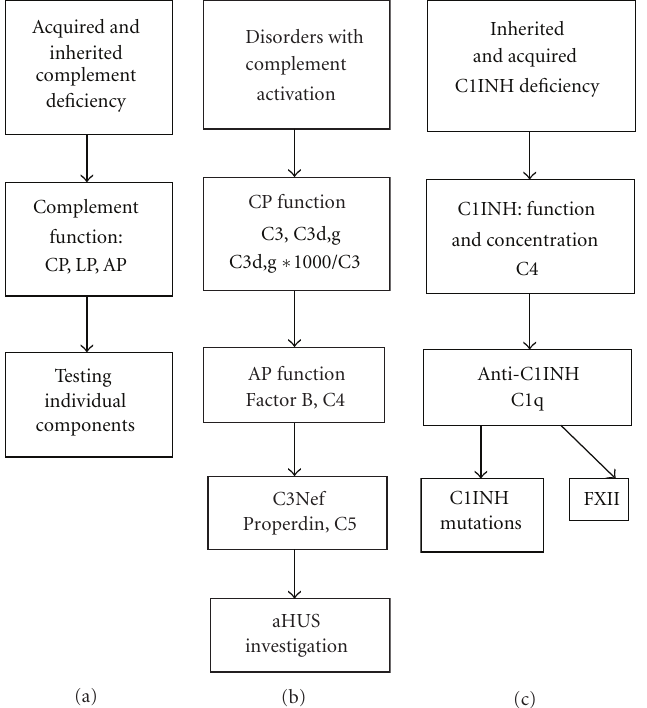
Figure 3: Algorithm for complement analyses. The aims are to diagnose complement deficiency in patients with recurrent bacterial infections (a), diagnose the cause of their persistent complement activation (b), and to dissect the cause of C1INH deficiency (c). See text (Section 5.1) for